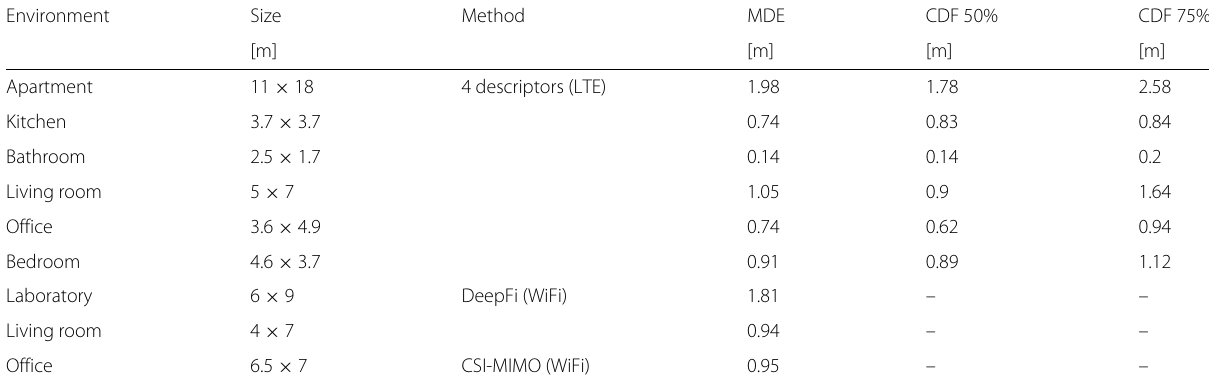
Table 6 Single room localization performance